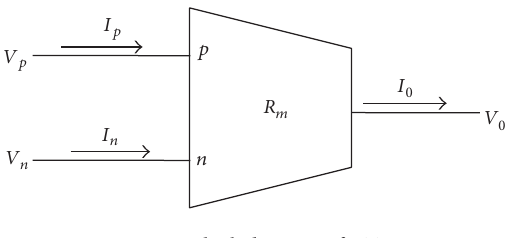
F 1: Block diagram of OTRA.